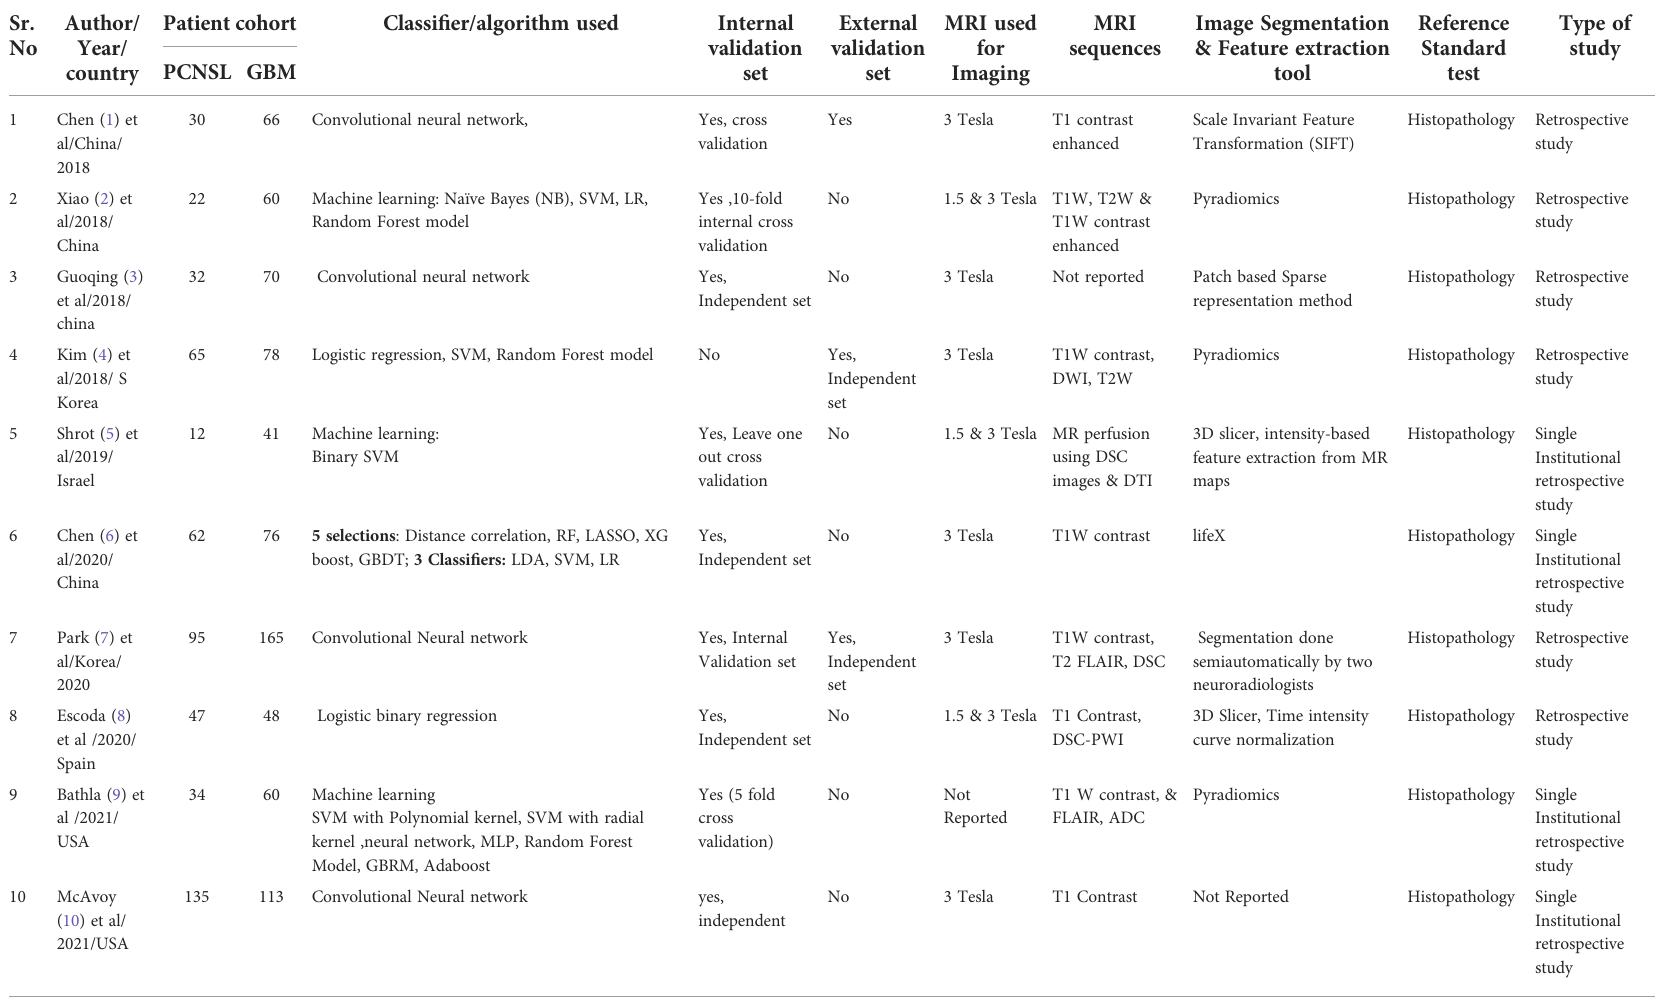
TABLE 1 Summary of the study pro fi le & methodology of the reviewed studies. Sr.